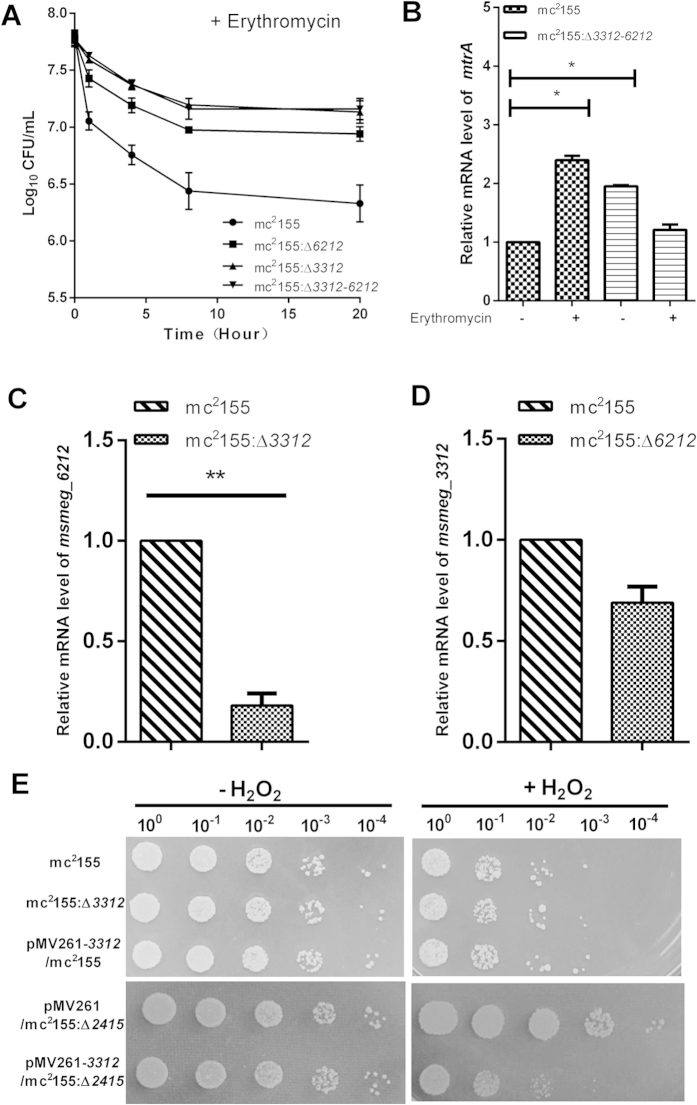
MSMEG_3312 and MSMEG_6212 have redundant roles in erythromycin susceptibility; MSMEG_3312, but not MSMEG_6212, has a redundant role in H2O2 susceptibility.(A) Killing curve for mc2155, mc2155:Δ3312, mc2155:Δ6212 and mc2155:Δ3312-6212 in 7H9 medium with 31.25 mg/L erythromycin. (B) Relative expression levels of mtrA in mc2155 and mc2155:Δ3312-6212 with (+) or without (−) erythromycin treatment. Levels of mRNA expression were determined by qRT-PCR. Results are shown as the mean ± standard deviations of three replicates (*p < 0.05). (C) Relative expression levels of msmeg_6212 in mc2155:Δ3312. Levels of mRNA expression were determined by qRT-PCR. Results are shown as the mean ± standard deviation of three replicates (**p < 0.01). (D) Relative expression levels of msmeg_3312 in mc2155:Δ6212. Levels of mRNA expression were determined by qRT-PCR. Results are shown as the mean ± standard deviation of three replicates. (E) H2O2 resistance phenotype of mc2155, mc2155:Δ3312, pMV261-3312/mc2155, pMV261/mc2155:Δ2415, pMV261-3312/mc2155:Δ2415. The pictures shown are representative of three independent experiments.